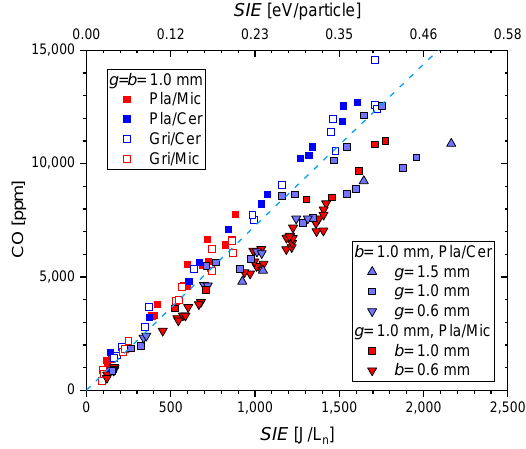
Figure 10. CO fraction as a function of specific input energy in the different plane parallel asymmetric DBD reactors. The color represents the dielectric, full symbols are for plate electrodes, and open symbols are for grid electrodes. The data measured with different gap and dielectric thickness are included.